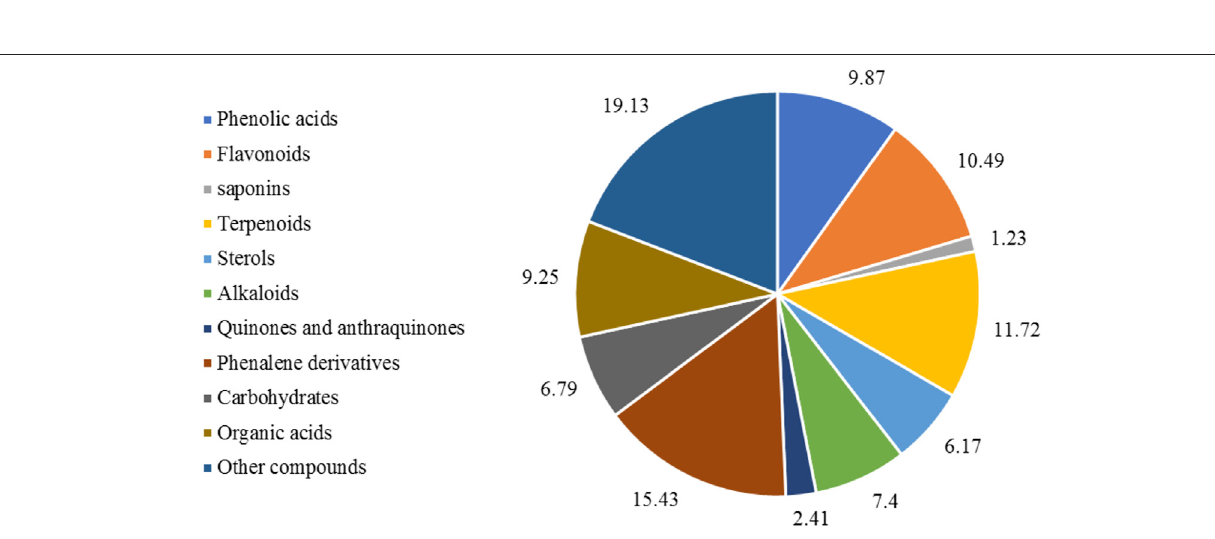
Frontiers in Pharmacology |